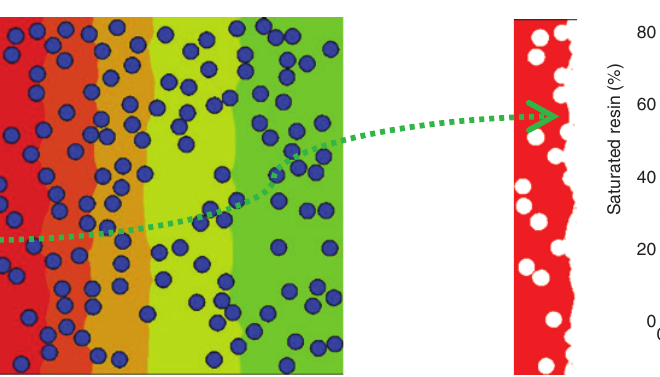
Figure 17: Image extraction to compute area fraction at a given time instance.